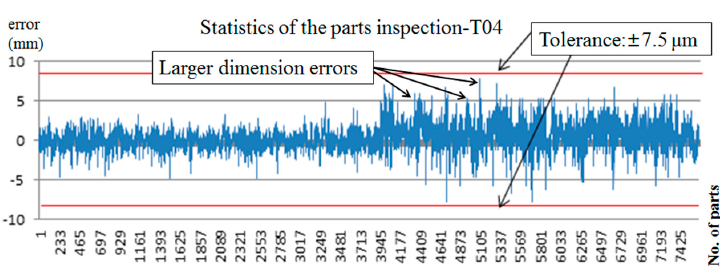
Figure 23. Statistics of parts inspection for T04.